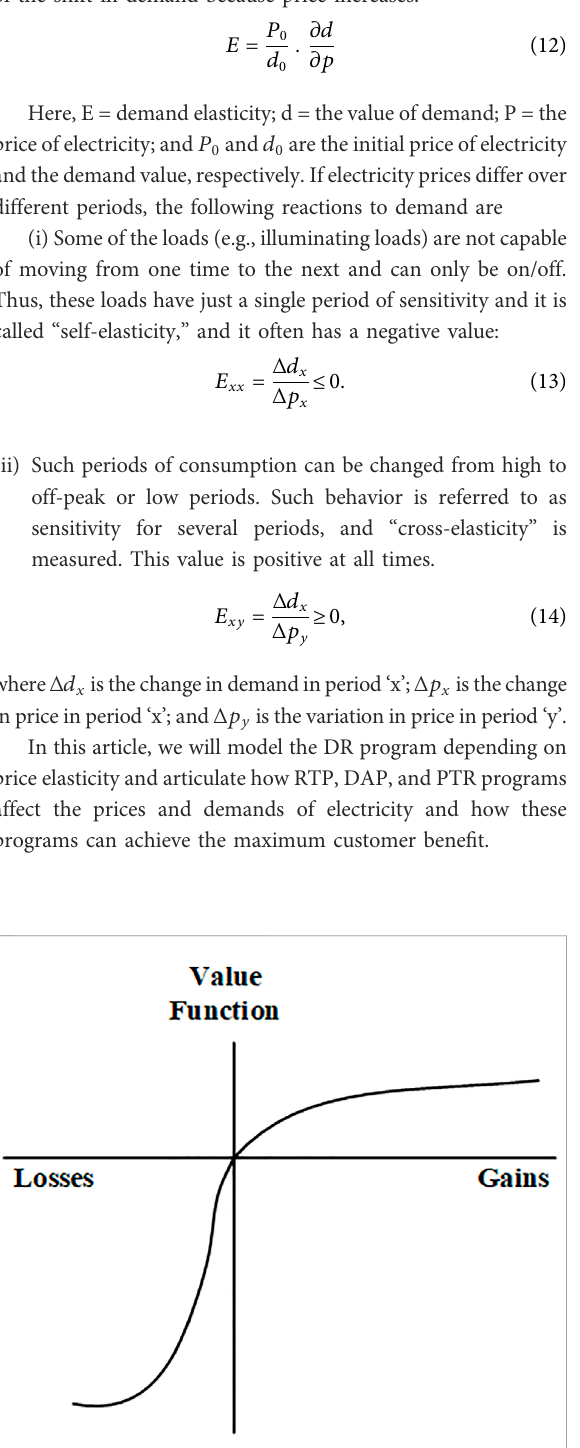
FIGURE 6 Price demand